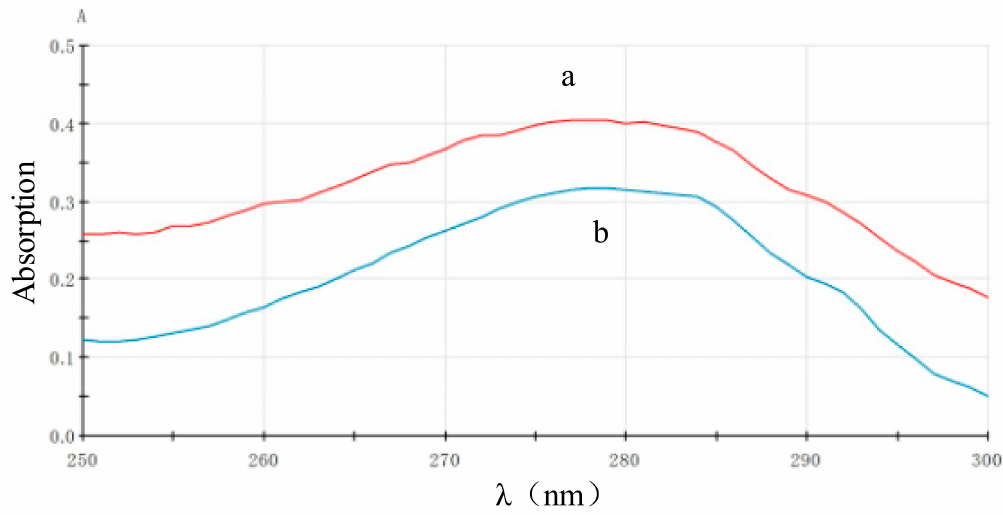
Figure 5. Absorbance spectrum of pcAb solution: before (a); and after (b) binding with magnet